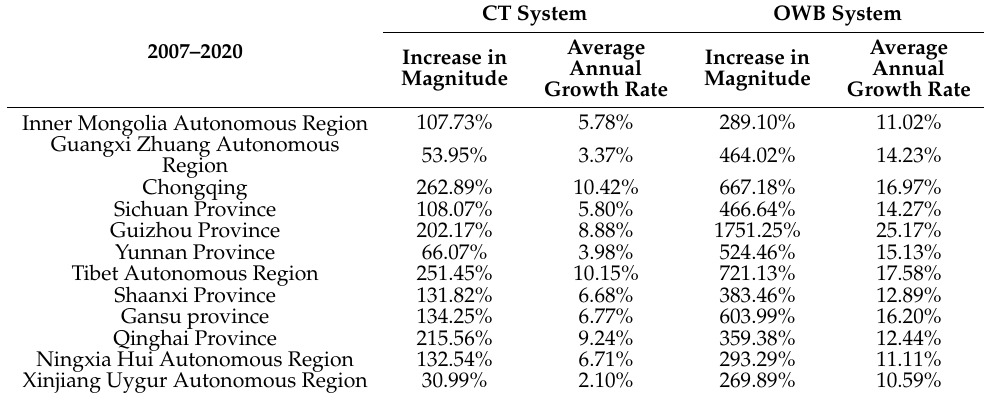
Table 4. Increased comprehensive evaluation values of CT and OWB in